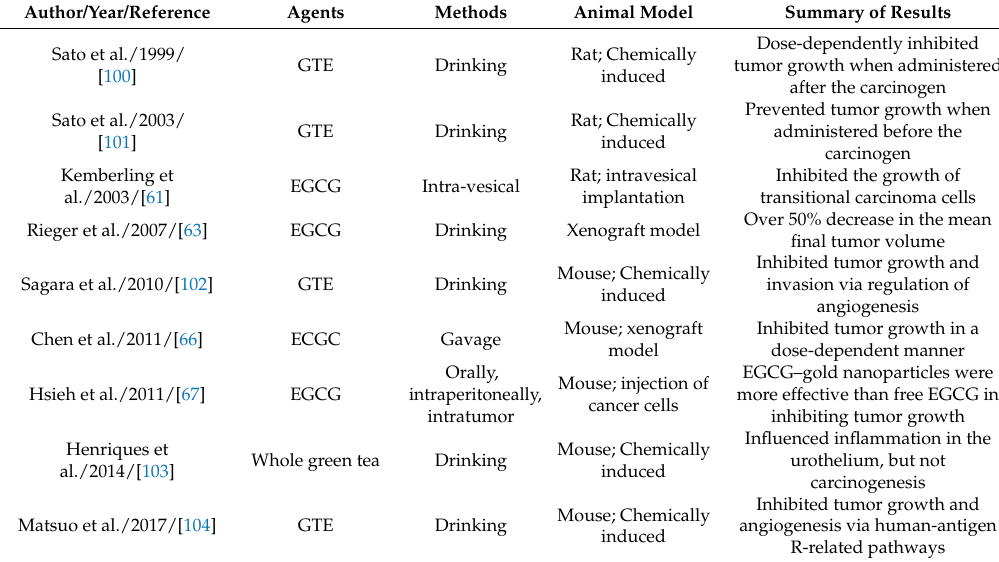
Table 5. Anticancer effects of green tea in animal models of bladder